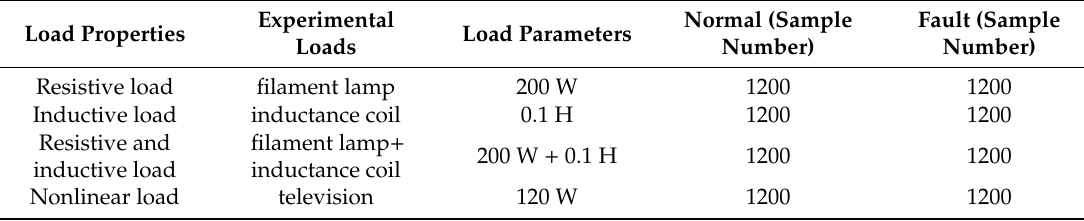
Table 2. Experimental load and